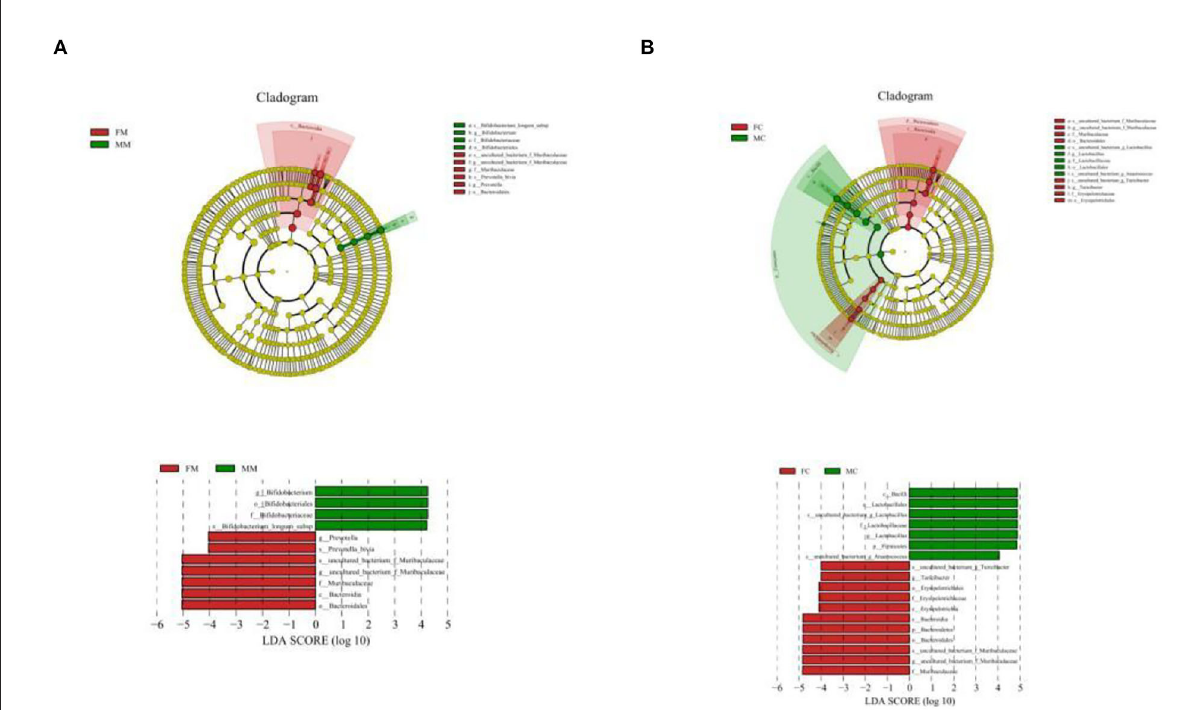
FIGURE6 Cladogram based on the line discriminant analysis effect size (LEfSe) analysis and linear discriminant analysis (LDA) value distribution histogram of MAM (A) and LM (B) . In this figure, species with no significant differences are colored in yellow, and other colors stand for different groups. The LDA histogram showed the species whose LDA score is higher than the set value (the default is 4.0). The length of the histogram represents the impact of different species (i.e., LDA score), and different colors represent species in different groups. Different colors represent species in different groups, and nodes with different colors represent microbial groups that play an important role in the group represented by the